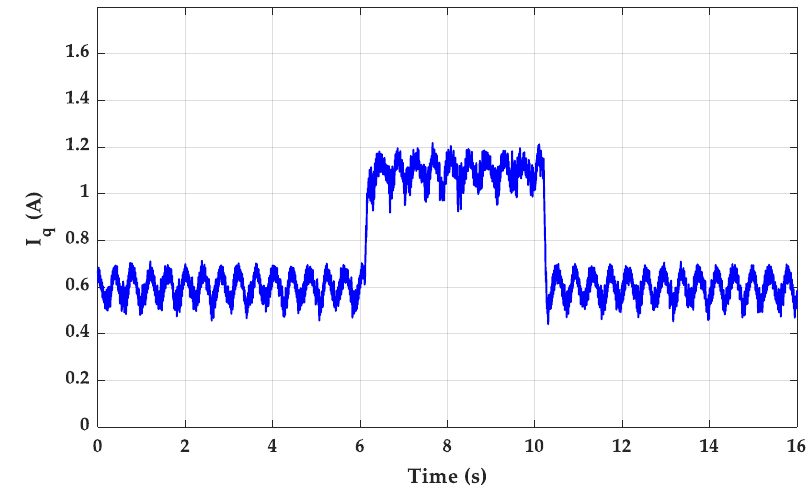
Figure 9. The VSI output q -axis current component (Experiment 1).